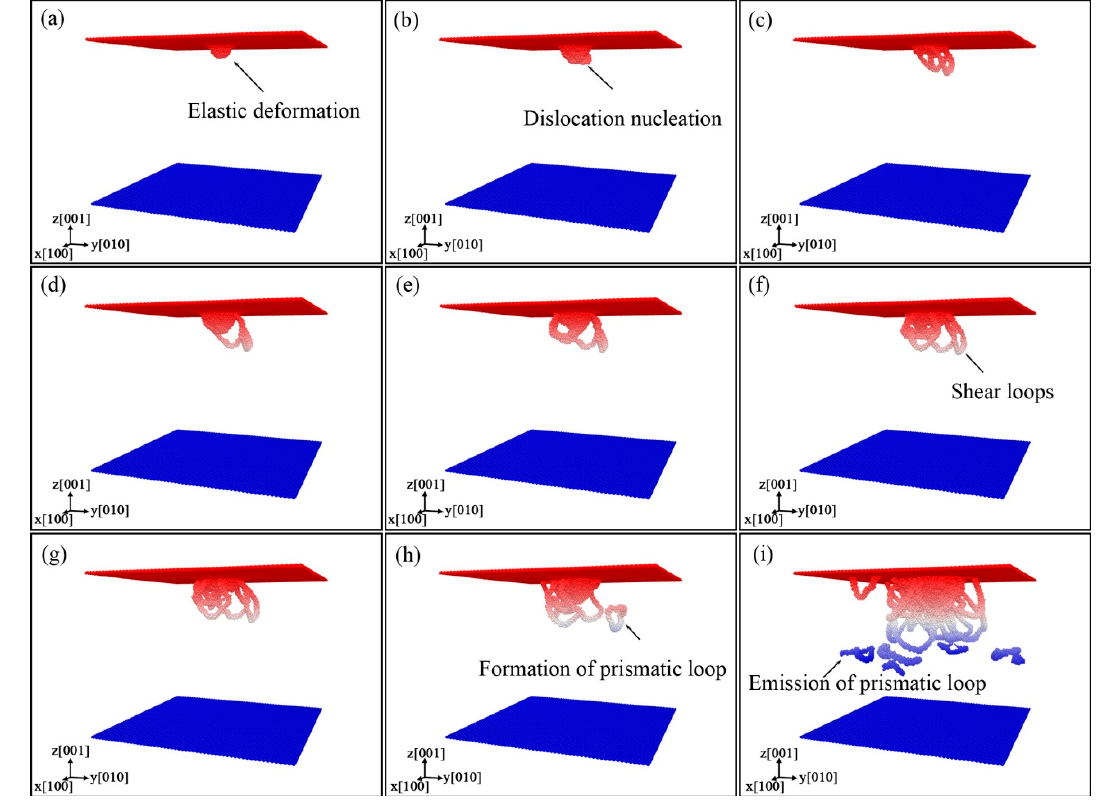
Figure 3. Distribution of dislocations in the specimen at different h : ( a ) h = 7.0 Å, ( b ) h = 12.2 Å, ( c ) h = 13.0 Å, ( d ) h = 14.0 Å, ( e ) h = 14.7 Å, ( f ) h = 16.7 Å, ( g ) h = 17.1 Å, ( h ) h = 22.3 Å, ( i ) h = 38.0 Å, with atoms colored by depth.